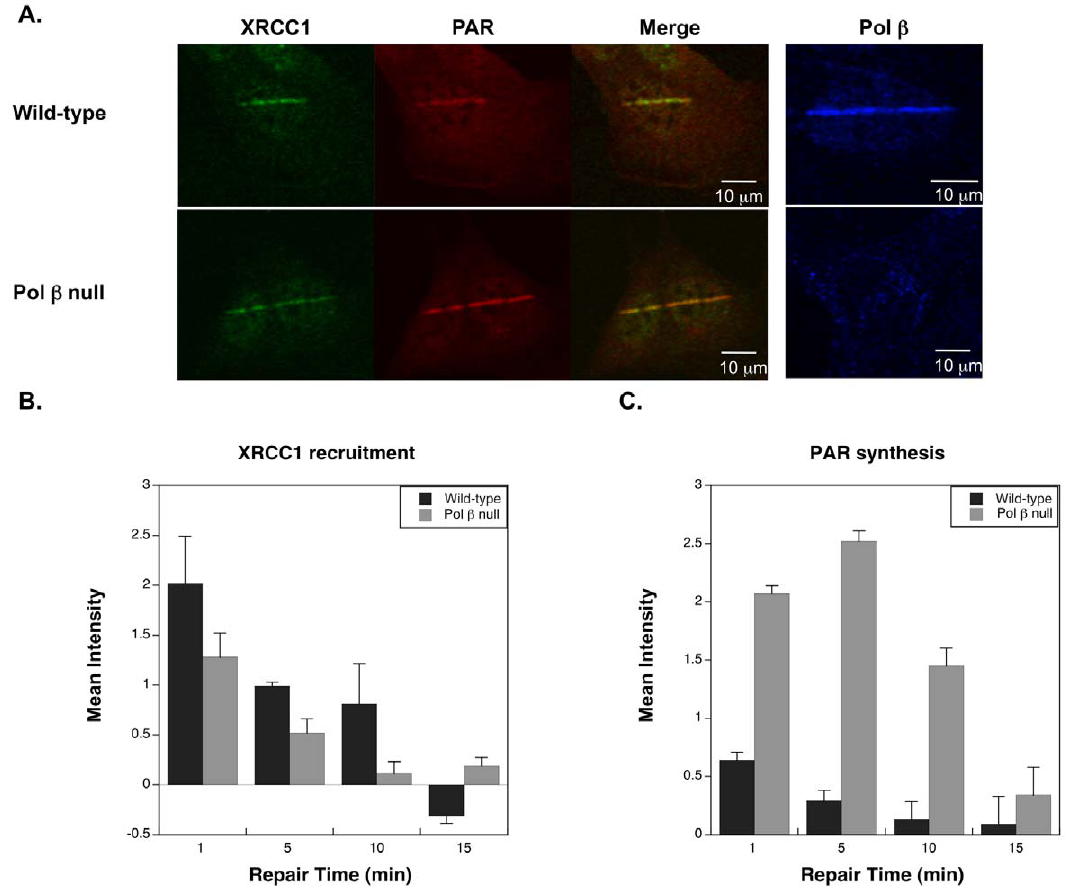
Figure 3. PARP-1 hyperactivation in pol b null cells in response to UV damage. A. Recruitment of BER proteins as indicated to the site of DNA damage in wild-type and pol b null cells one minute after irradiation. B. Time course of XRCC1 recruitment to the site of damage with the repair times specified. C. PAR synthesis at the site of damage with the repair times specified. Images are representative; at least five cells were measured for every time point and error bars reflect SEM.